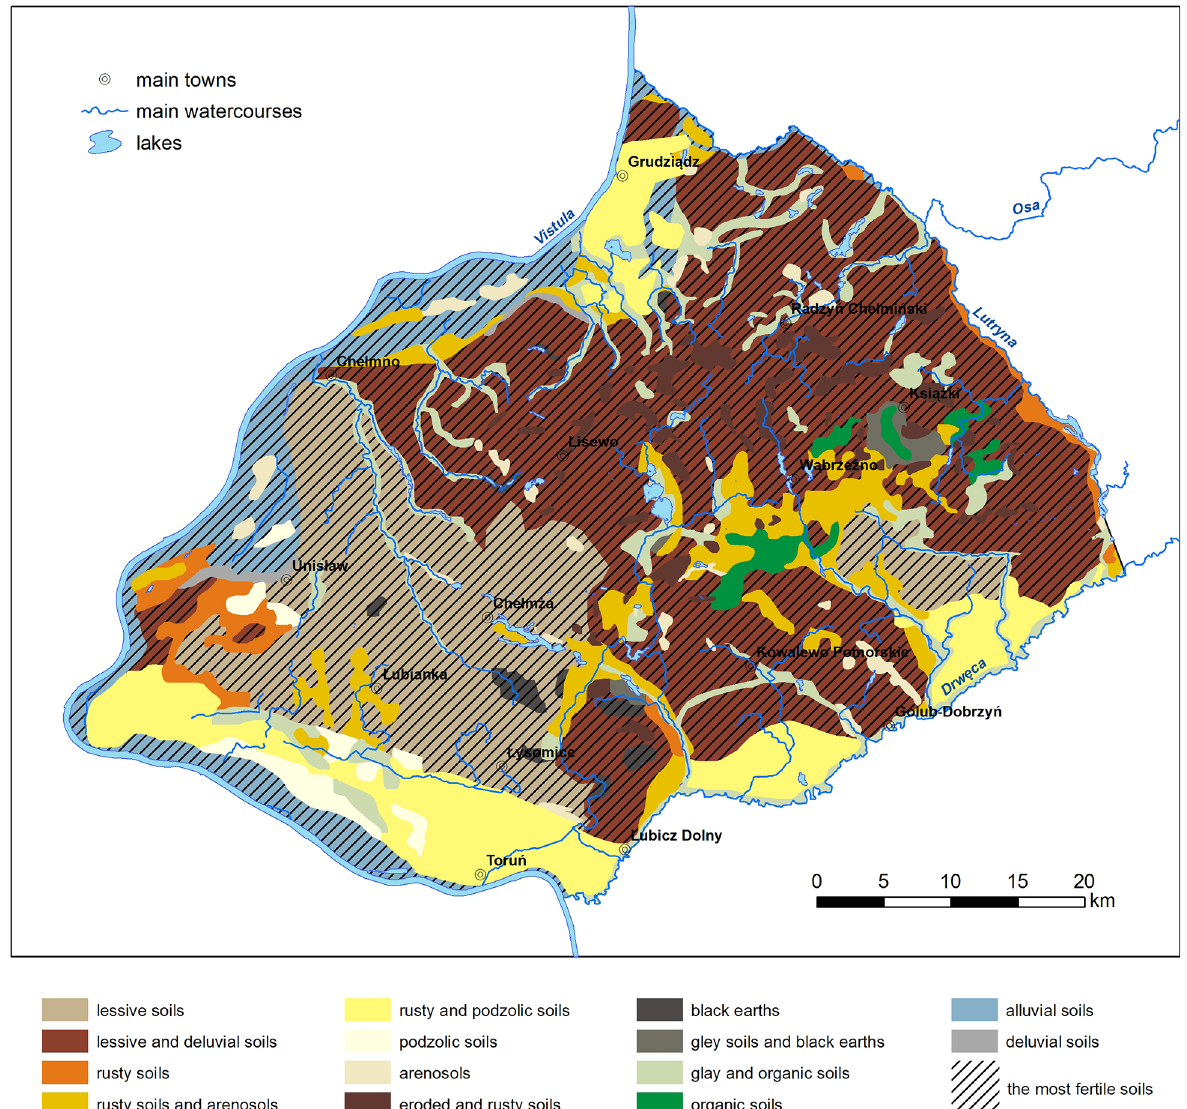
Fig. 5. Soil map based on Bednarek et al.